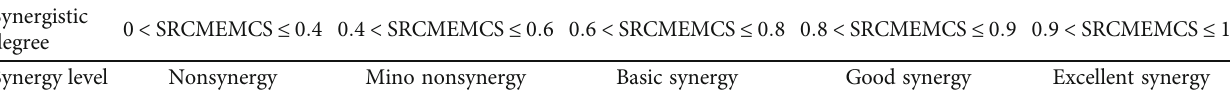
Table 1: Evaluation standard of